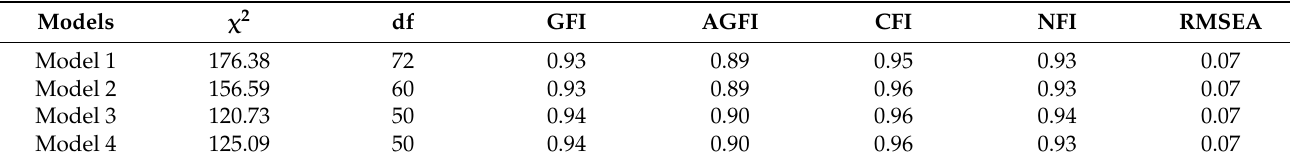
Table 3. Fit indices for all hypothetical